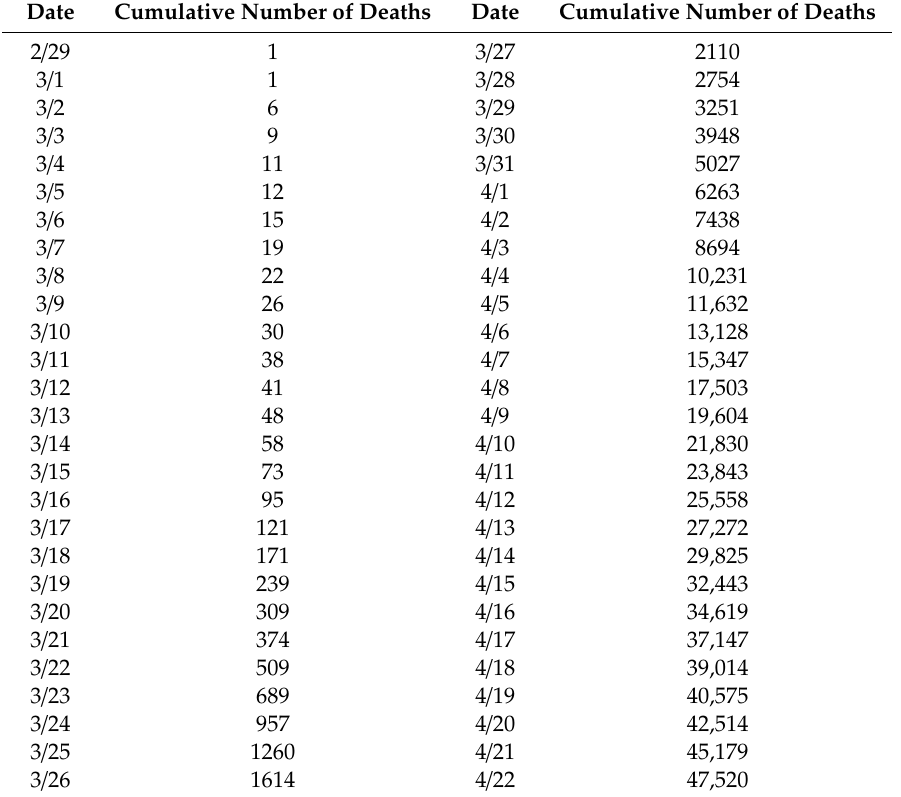
Table 3. US deaths data [20] during 2 / 29 / 20—4 / 22 / 20.